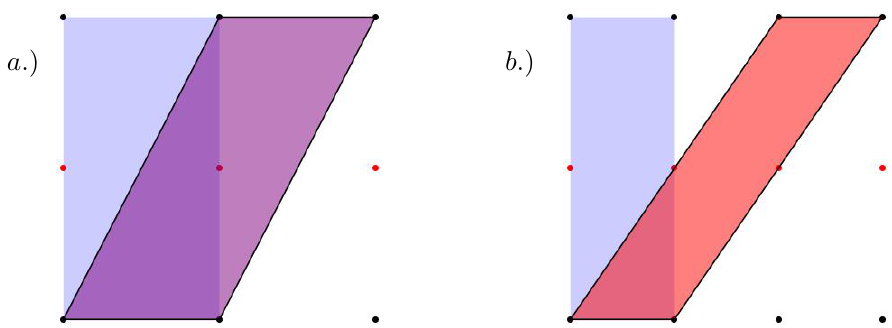
Figure 2 . Above we have chosen a fundamental domain colored in blue for E (cid:28) the depiction of a 2-torsion point (cid:28) + (cid:3) (cid:28) in orange. We act on the basis by the generator T in a: ) which translates 2 the point (cid:28) + (cid:3) to (cid:28) +1 + (cid:3). In b: ) we act on the fundamental domain by T 2 in to obtain the pink 2 2 one while (cid:12)xing the torsion